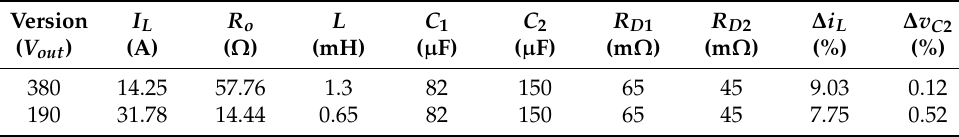
Table 4. Parameter design values for both versions of boost